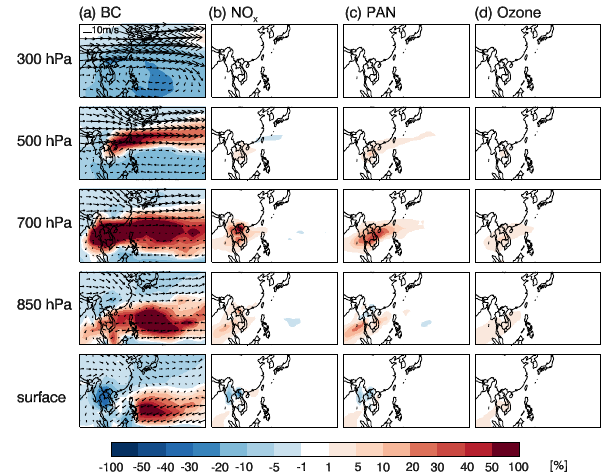
Fig. 6. Percent changes of pollutant concentrations in the MISR- constrained simulation relative to the control simulation for (a) BC, (b) NO x , (c) PAN, and (d) ozone at five altitudes during March 2001. Arrows indicate the monthly mean